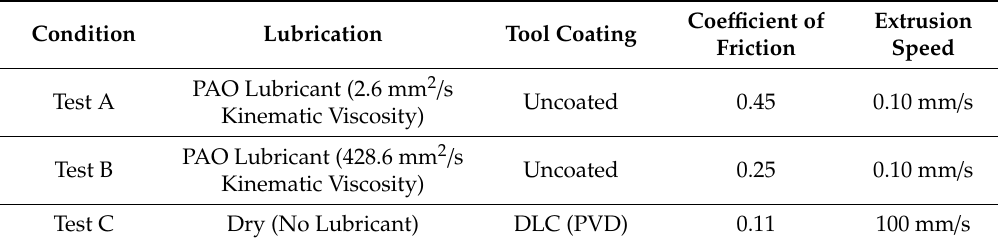
Figure 3. The finite element simulation setup of the micro-extrusion process. Table 1. Experimental validation conditions for the finite element (FE) model.